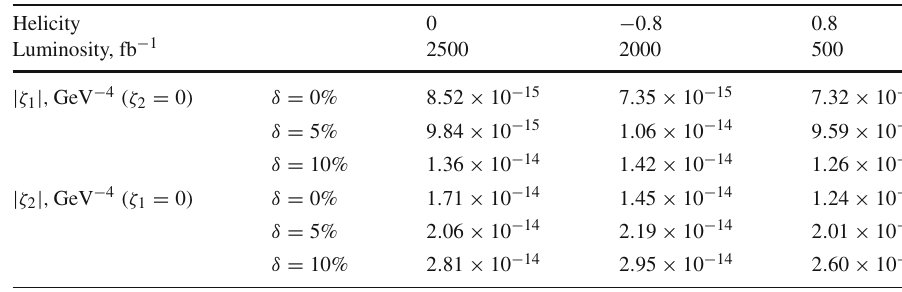
Table 3 The same as in Table 2, √ s = 3000 GeV but for